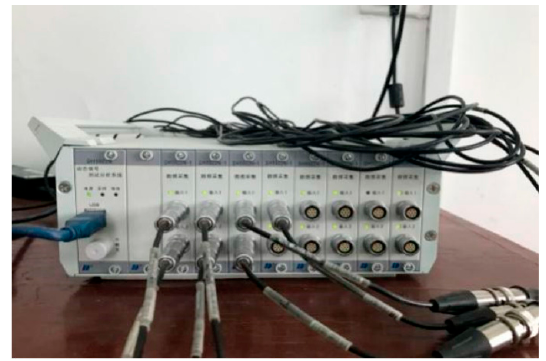
Figure 11. DH5922 vibration testing system